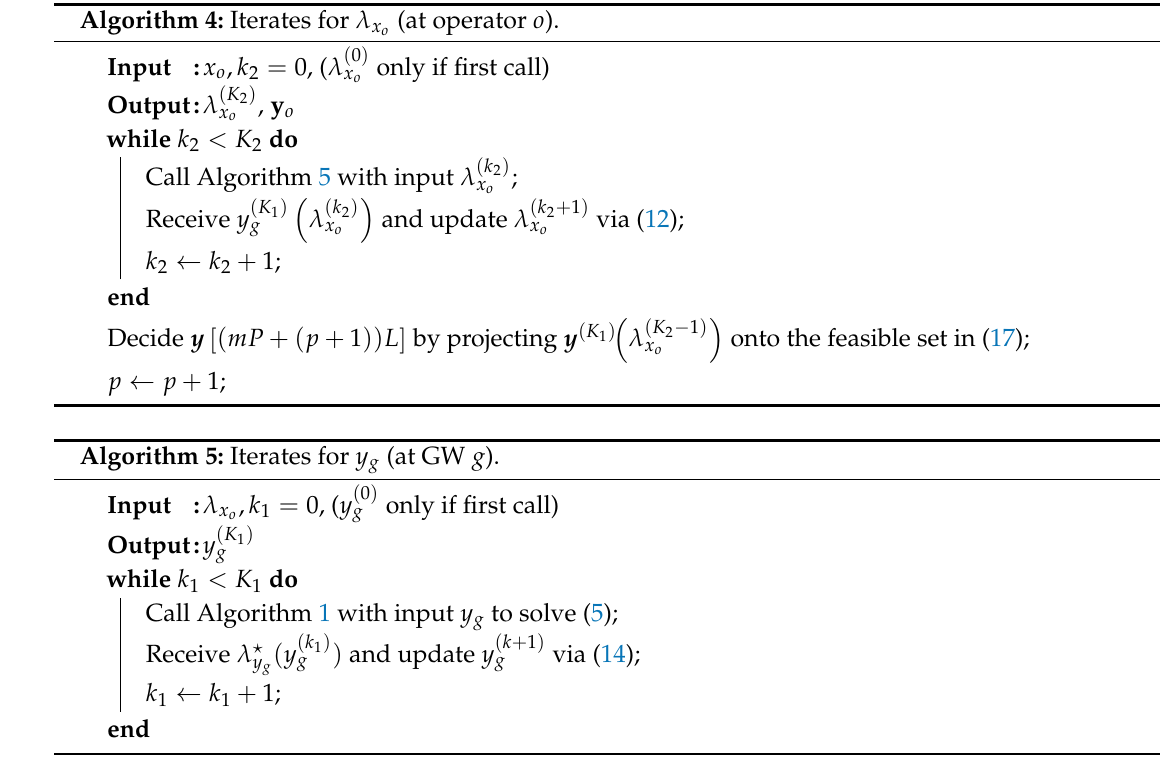
(at operator o ). o